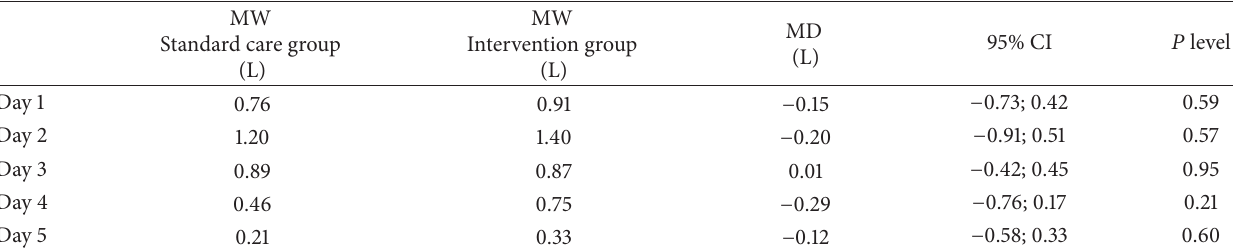
Table 4: Daily fluid balance.